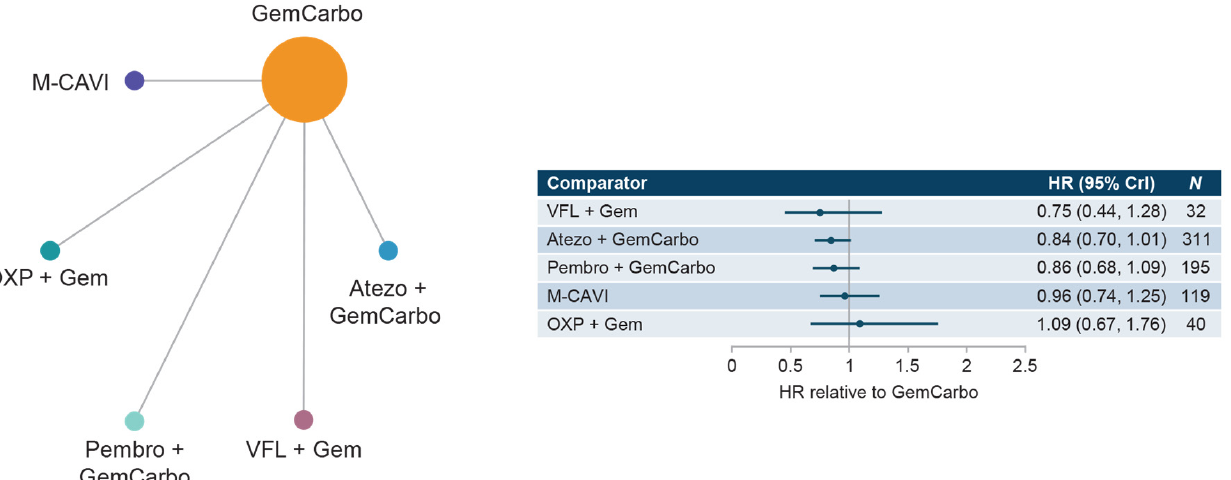
Figure 5. Network diagram and HR for PFS by treatment network for the cis-ineligible (wide) net- work. Abbreviations: Atezo, atezolizumab; cis, cisplatin; CrI, credible interval; Gem, gemcitabine; GemCarbo, gemcitabine + carboplatin; HR, hazard ratio; M-CAVI, methotrexate + carboplatin + vin- blastine; OXP, oxaliplatin; Pembro, pembrolizumab; PFS, progression-free survival; VFL, vin- flunine.